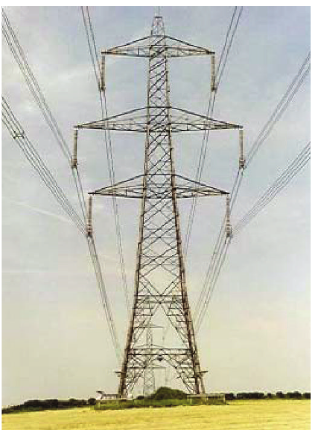
Figure 9: The monitored L6 transmission line